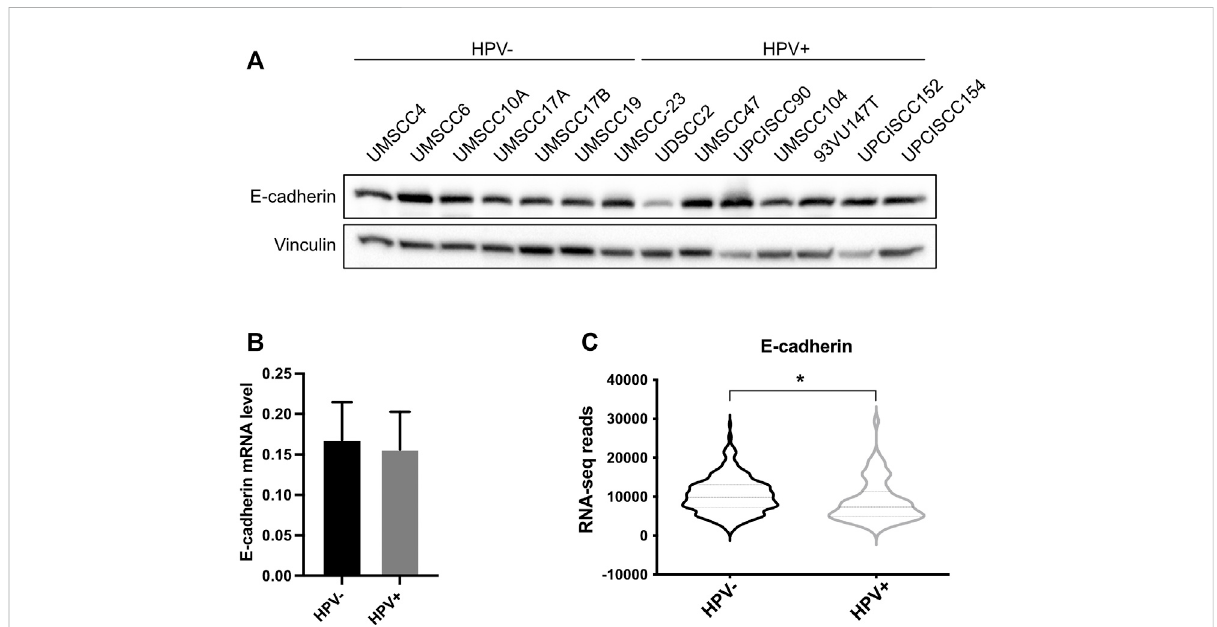
FIGURE 3 Analysis of E-cadherin expression in HPV-positive and HPV-negative HNC. (A) HNC cell lines were lysed and analyzed by immunoblotting with the indicated antibodies (FL, full-length). (B) Total RNAs from HNC cell lines were isolated for RT-qPCR. E-cadherin expression was normalized to RpP0andshown asmeans±SEMofatleastthreeindependentexperiments. (C) NormalizedRNA-seqdatawereextracted fromTCGAdatabase and divided in HPV-positive and HPV-negative HNC cohorts. *, p < 0.05 (unpaired t